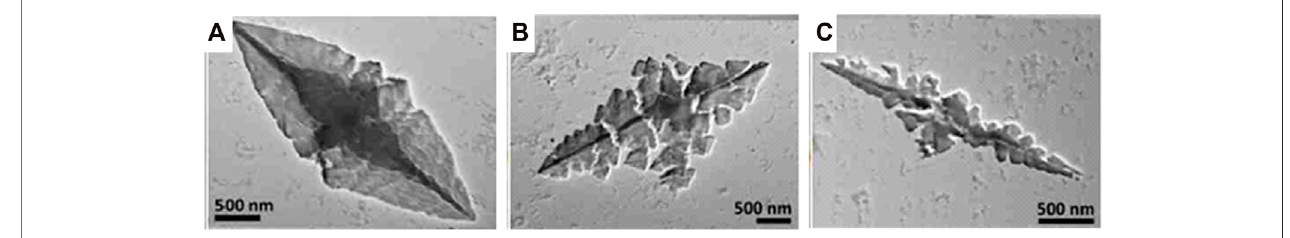
FIGURE2| Cationic-anionicdi-porphyrinneedles:( A – C )TEMimagesofneedlesformedbyanassemblyofanionictetra-(4-sulfonatophenyl)porphyrinandcationic tetra-(N-methyl-4-pyridyl)porphyrin with different ratios (Düring et al., 2018). Reprinted with permission. Copyright © 2018, Springer-Verlag GmbH Germany, part of Springer